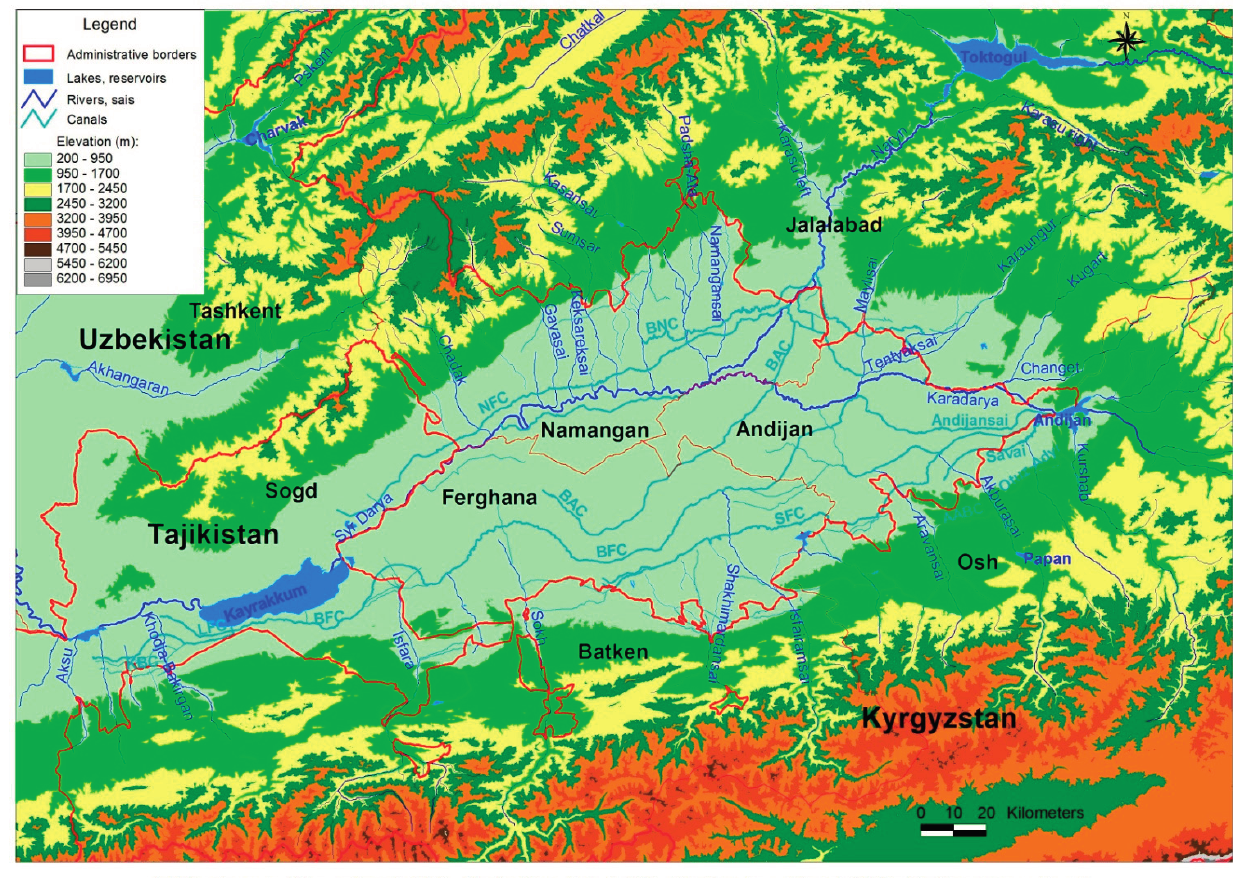
Figure 1. Topography, transboundary water resources and infrastructure in the Ferghana Valley (map by Alexander Platonov, 2015; courtesy of the International Water Management